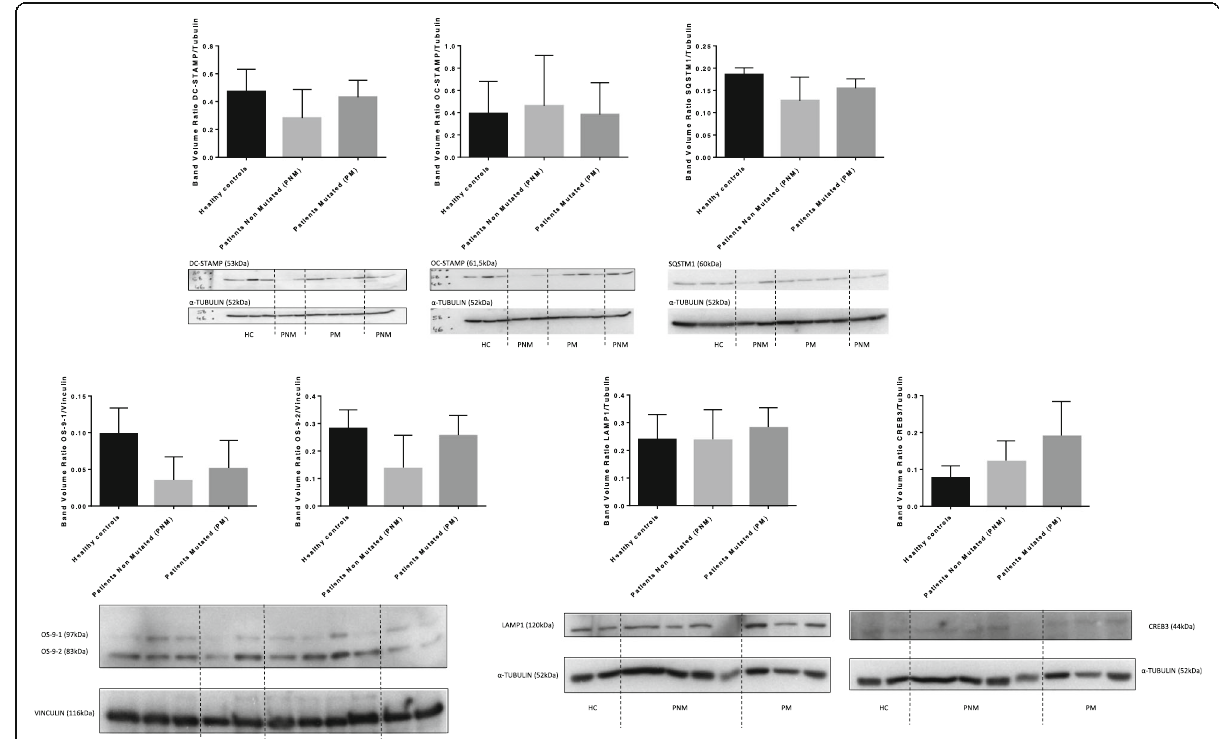
Fig. 4 Protein expression analyses quantified by Western blot from cell lysates of in vitro differentiated